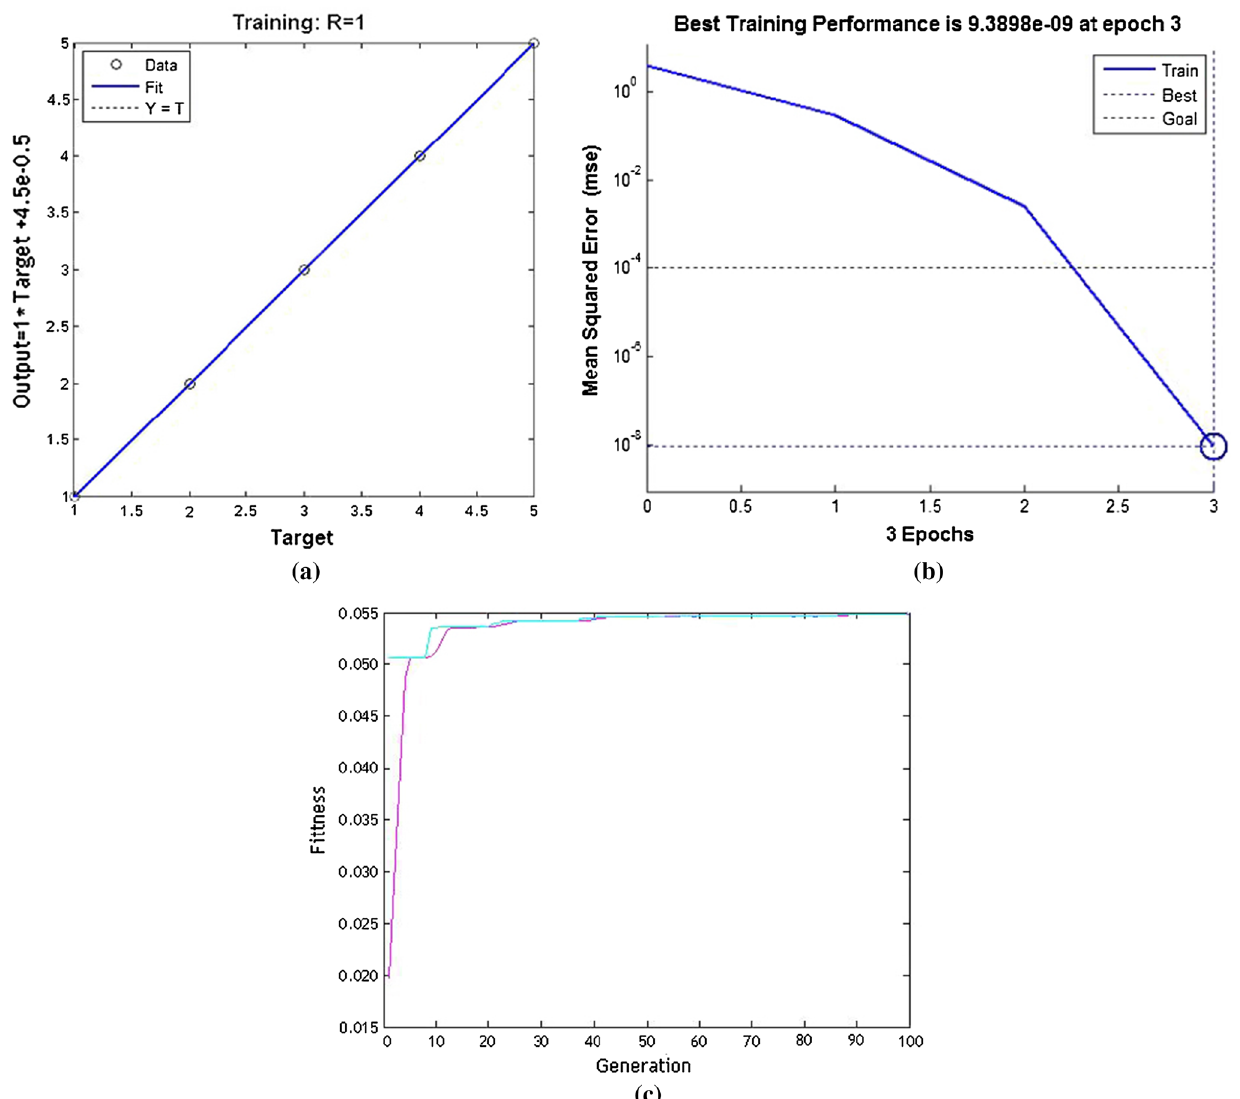
Fig. 8 Results about GA-BP network: a regression function: X axis of the regression function is the target accuracy, and Y axis is the accuracy of network training; b the accuracy performance function: